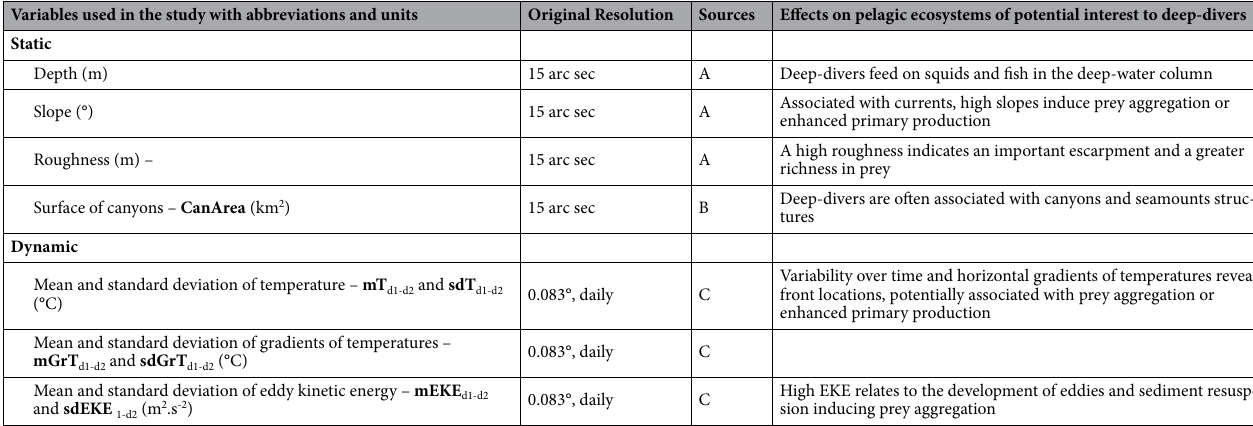
Table 3. Candidate environmental predictors used for the habitat-based density modelling. A: https:// www. gebco. net/; 15 arc-second is approximately equal to 0.004°. B: Harris et al. 62 . C: Iberian Biscay Irish- Ocean Physics Reanalysis model from Copernicus (https:// doi. org/ 10. 48670/ moi- 00029). All dynamic variables were extracted or computed for each depth class (surface, 0–200 m, 200–600 m and 600–2000 m). Abbreviations used in the following article are defined here in bold, d1-d2 refers to the depth classes e.g. 200–600 means between 200 and 600 m. In the analyses, all variables were resampled or used at a 0.083° spatial